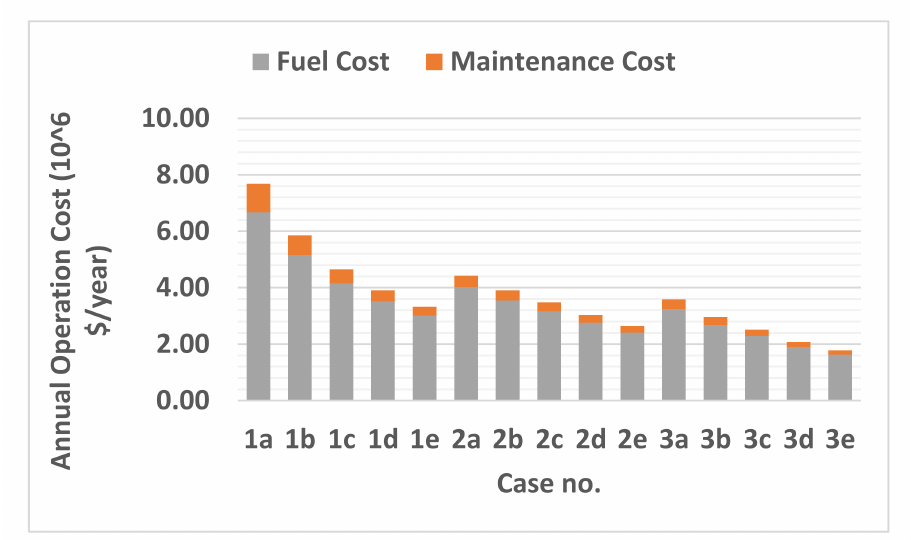
Figure 9. Annual operating cost break down for each case study.